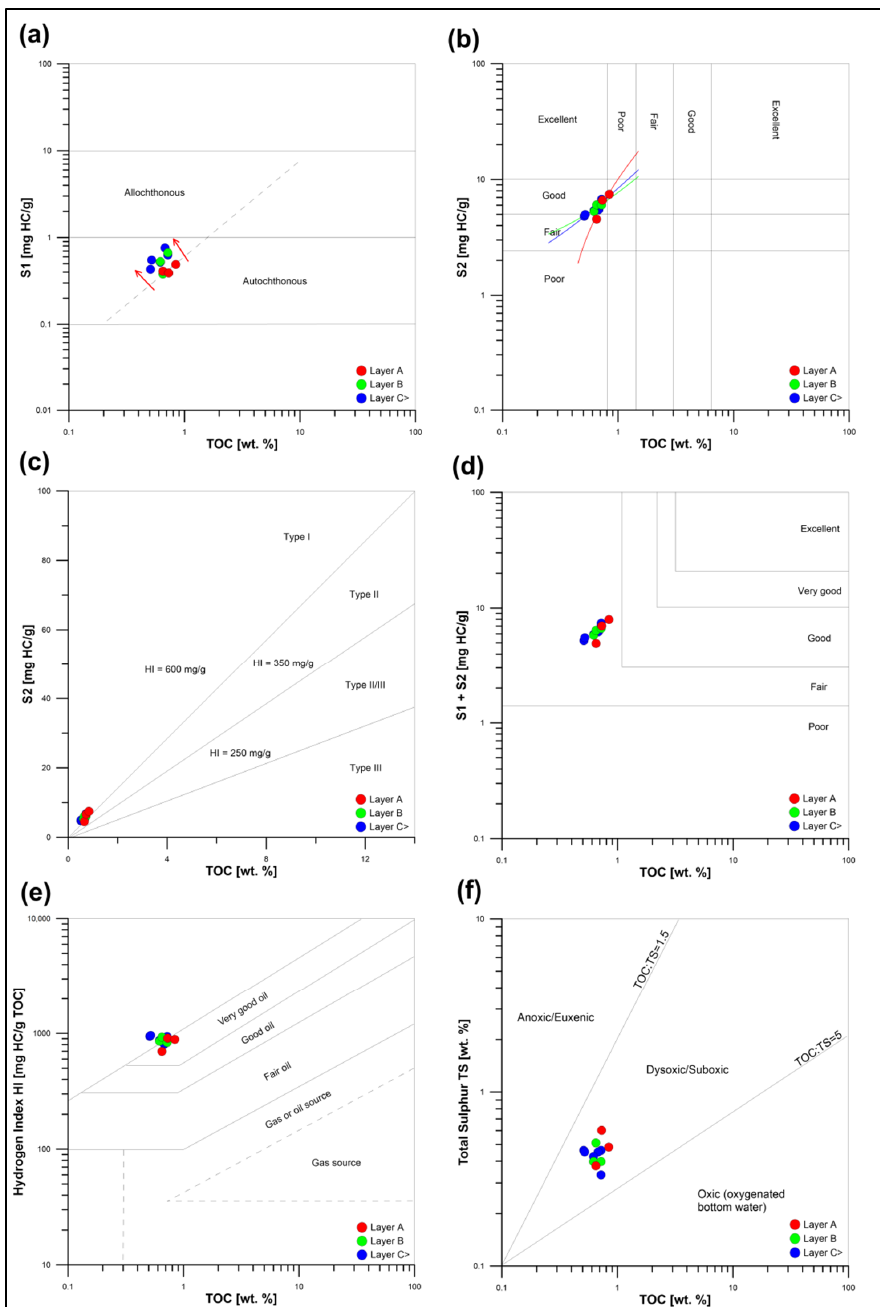
Figure 5. The pseudo-van Krevelen diagrams ( a – f ) based on R–E6 data: ( a ) the relations between auto- and allochthonous organic matter; the slight increase in the amount of allochthonous organic matter with the burial depth is shown by red arrows; ( b ) comparison between TOC contents and generated hydrocarbon potential ( S 2 ); the trend lines indicate a slight increase in generated hydrocarbon potential occurring with burial depth; ( c ) relations between TOC , S 2 , and HI , revealing type I kerogen (oil-prone), usually 600 mg HC/g TOC or above; ( d ) the fair generation potential indicated by TOC and GP ; ( e ) the immaturity (or very good oil potential) of samples shown by TOC and HI data; slight decrease in potential was observed with burial depth and in relation to the consumption of organic matter; ( f ) the suboxic to dysoxic conditions of the sedimentary environment visible due to the comparison of TOC and TS data.